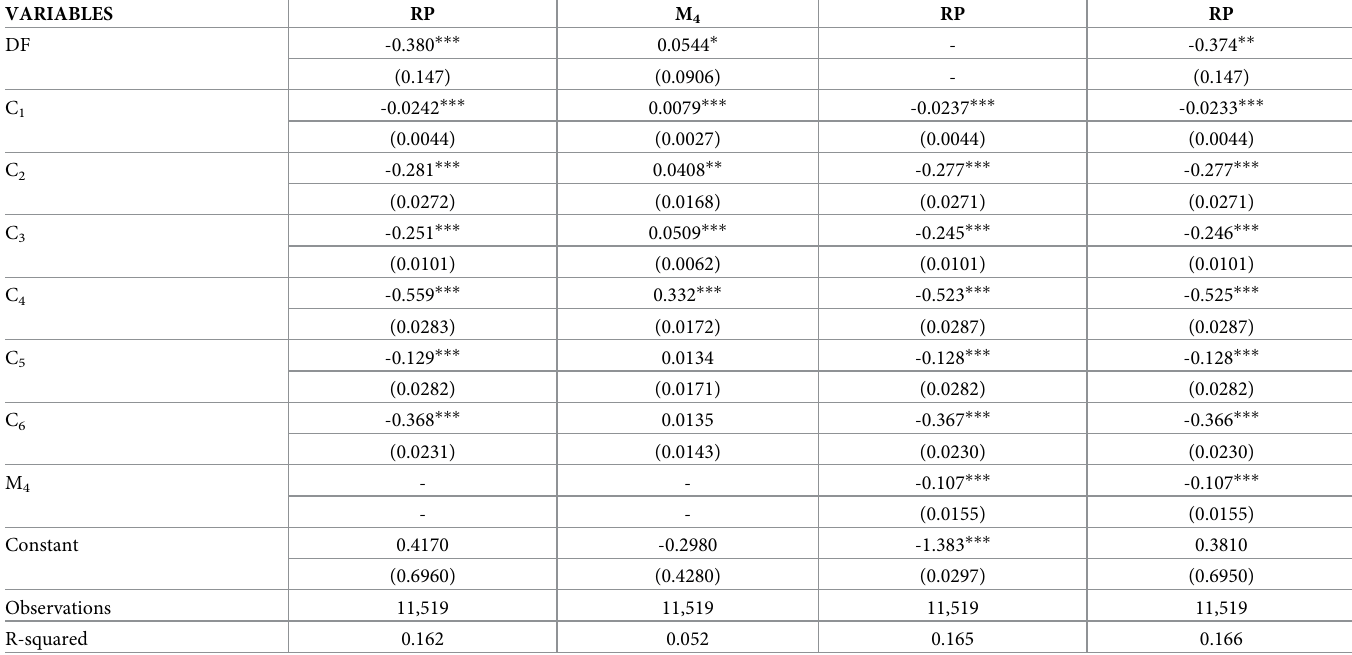
Table 10. Robustness test of the mediation effect of family